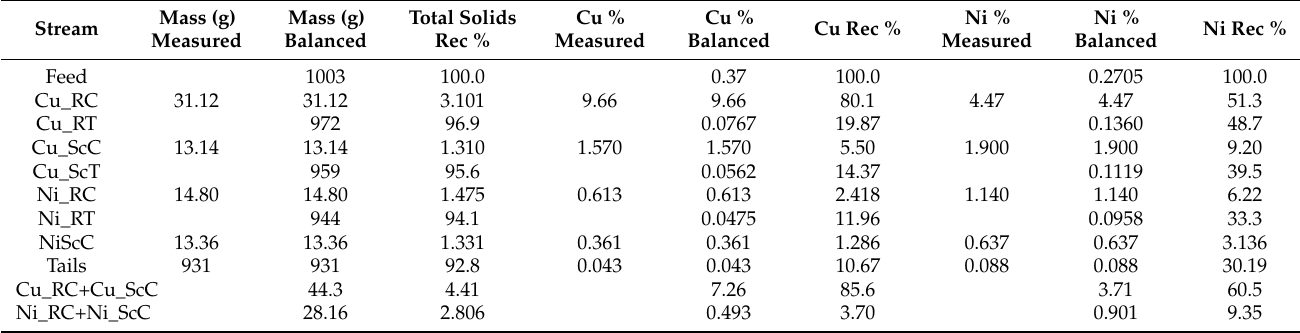
Table A3. Mass balance for flotation test Sep